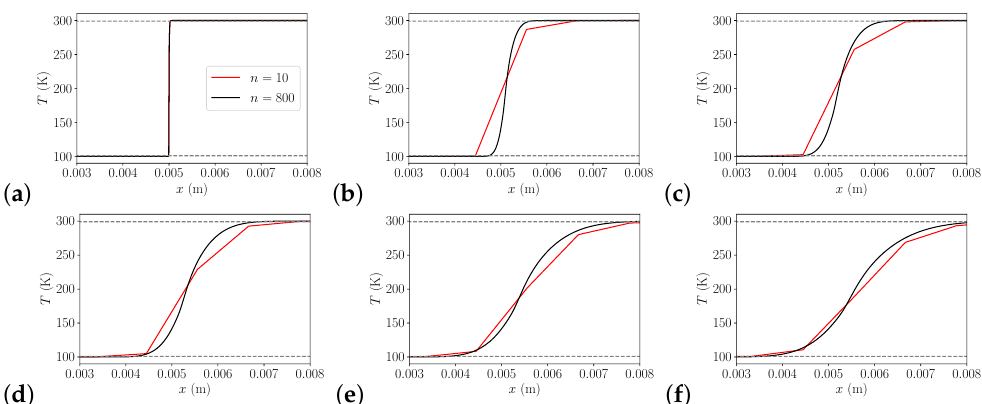
Figure 17. Plot of the temperature along the domain of the mesh at different time steps, ( a – f ) corre- sponding to t = 0,0.25,0.5,1,2,3 (s). The red line is a simulation using ANN fluid property models { } on a coarse mesh of n = 10 elements, and the black line is a case on a fine mesh of n = 800 elements using ANN fluid property